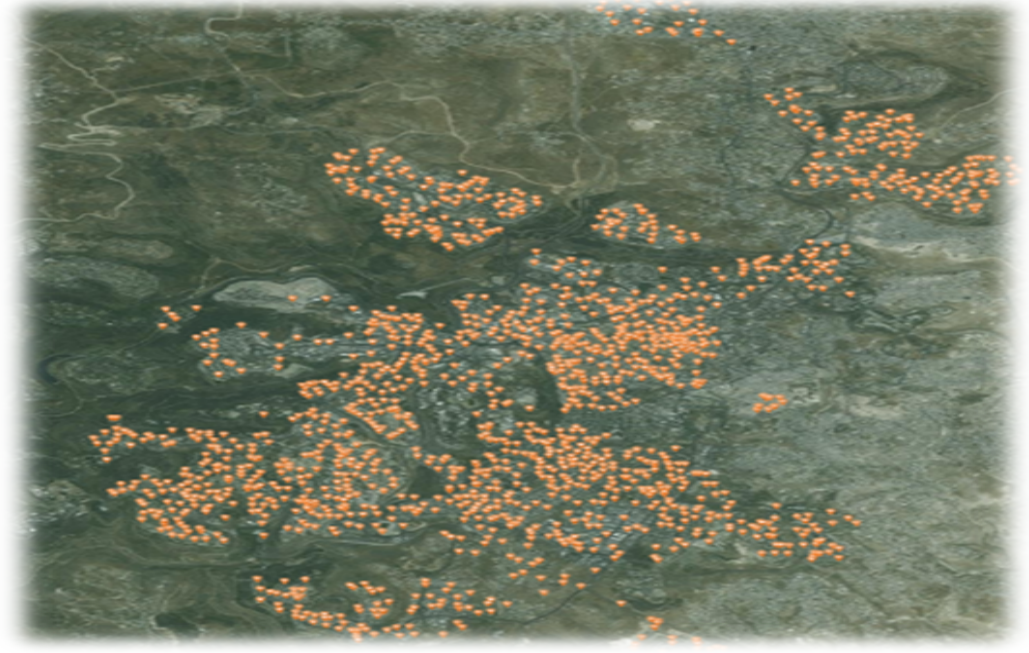
Figure 3: Location of acoustic sensors on the map (water supply network) of Jerusalem (1600 sensors, 750 km of the